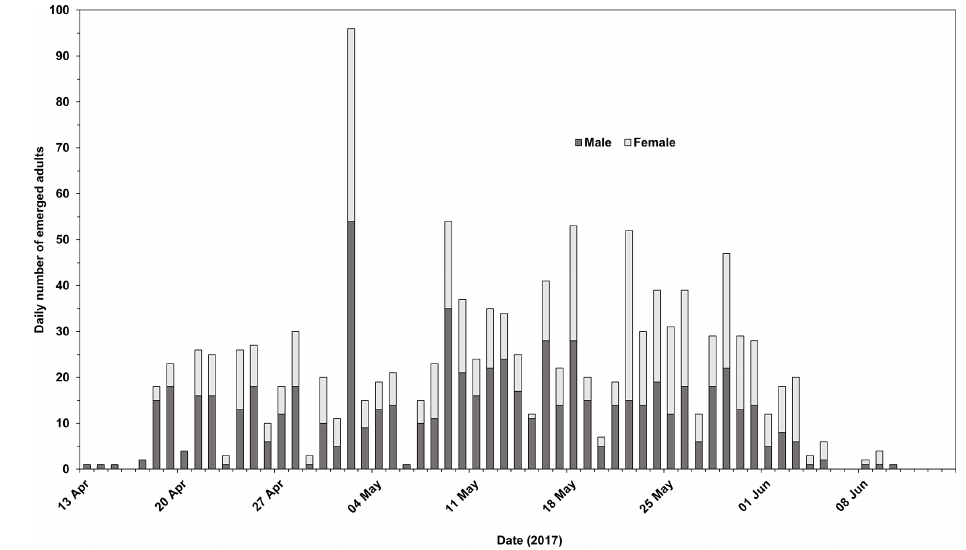
Figure 1. Emergence timing of male and female Chaoborus obscuripes . Males appeared to emerge slightly earlier than females.